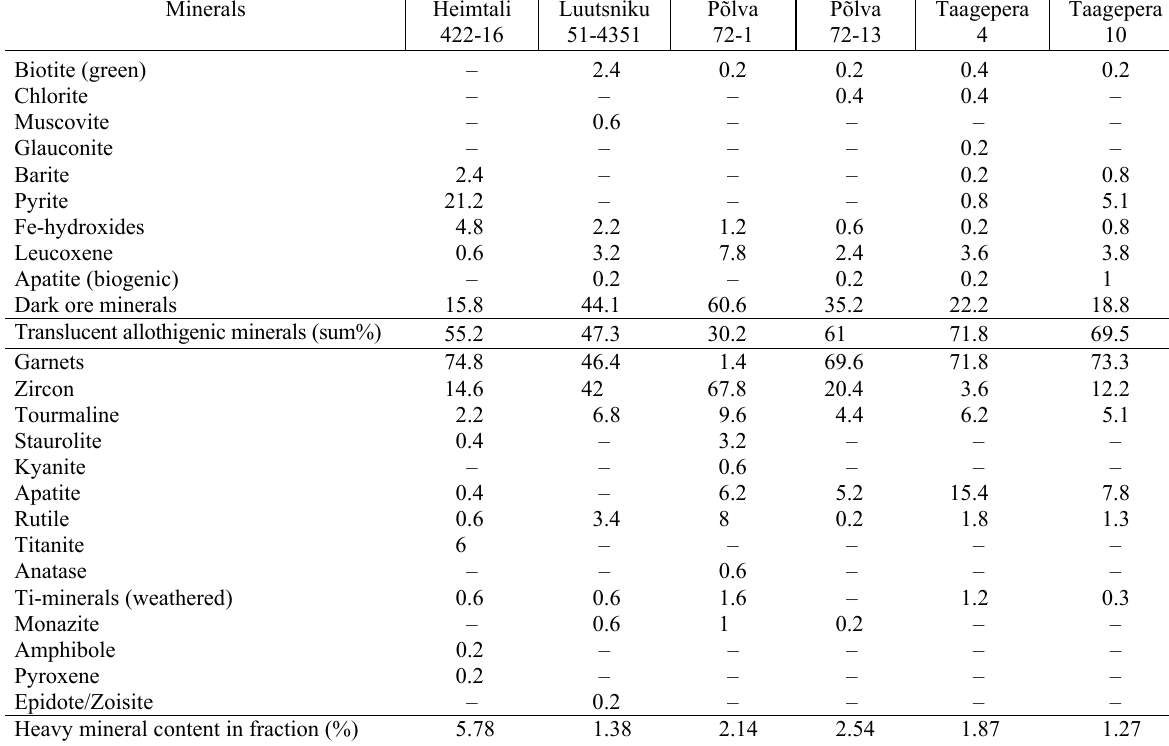
Table 6. Results of optical microscopy analysis of Devonian sandstone samples (grain counts (%), fraction 0.05–0.1